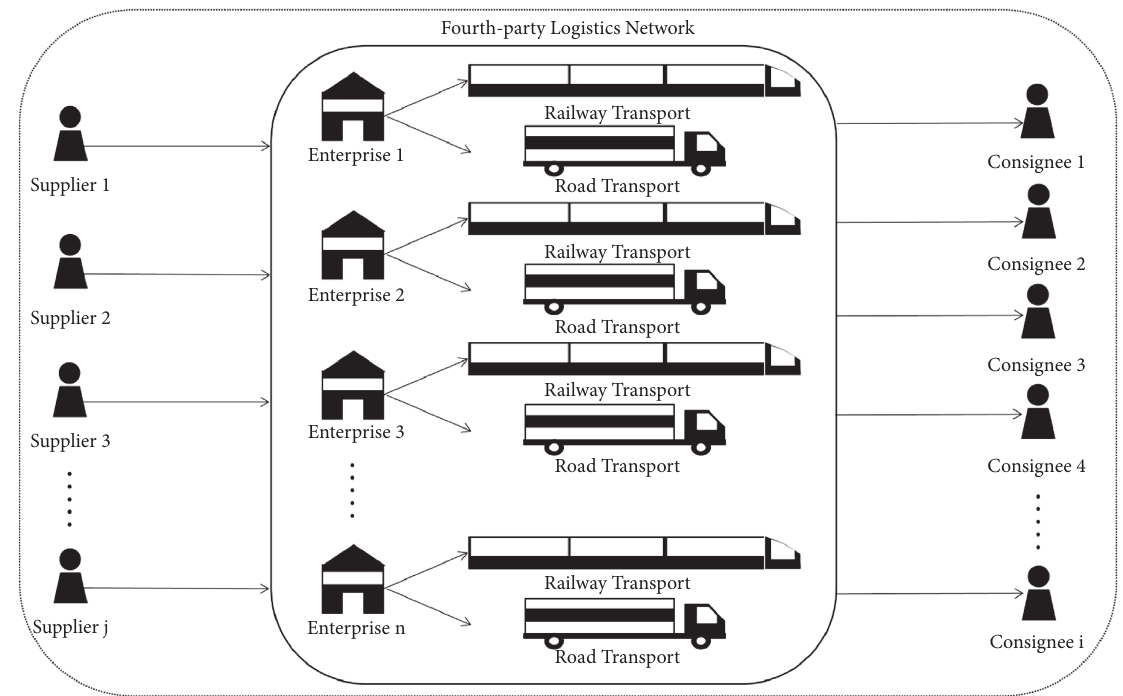
Figure 2: The fourth-party logistics network for bulk